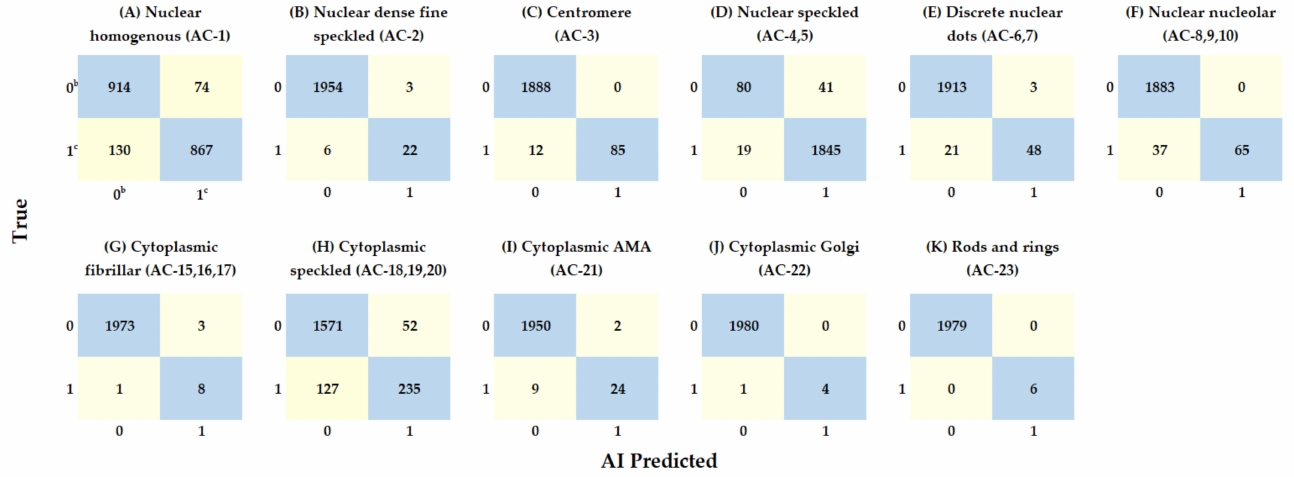
Figure 4. ( A – K ) Confusion matrices of the best performance proposed model (InceptionResNetV2) on sample prediction on Testing Data 1 a . a Consists of 1985 samples with 6195 images b 0: negative, c 1: